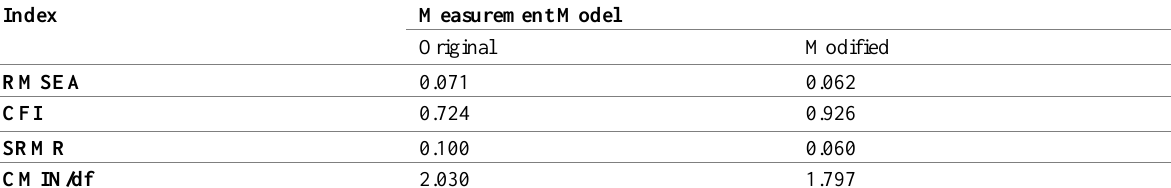
Table 3: Model fit indices for original and modified measurement models.